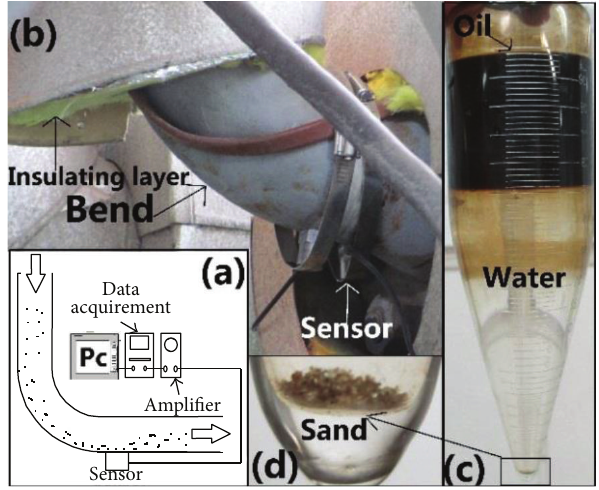
Figure 1: Schematic diagram of sand monitoring: (a) illustration of the sand monitoring facility, (b) sensor field installation graph, (c) the 100 mL crude oil from pipeline after centrifugation, and (d) amplified sand